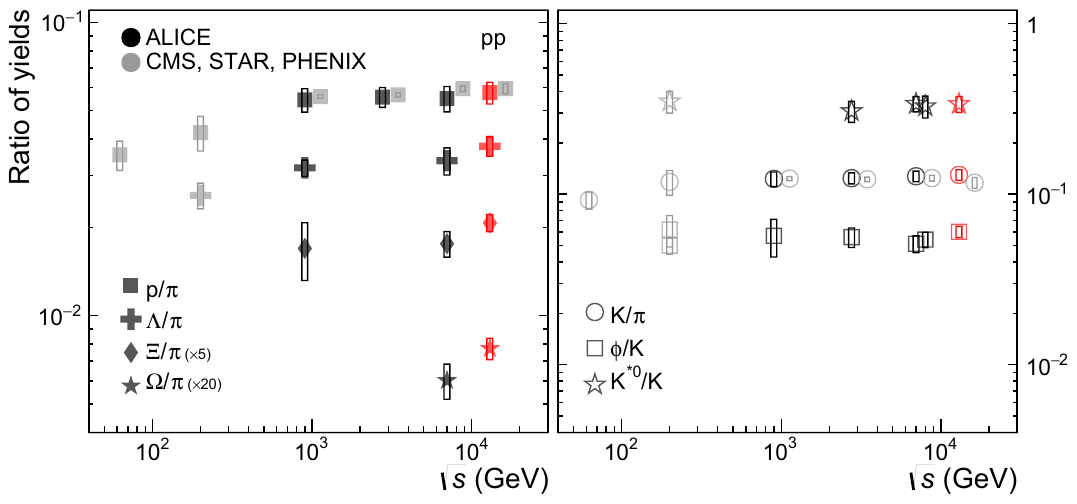
√ s = 62 . 4 GeV obtained at BNL RHIC. The CMS data points are at slightly shifted horizontally for clarity. Open boxes represent statistical and systematic uncertainties summed in quadrature. Red data points are √ s = 13 ALICE measurements for